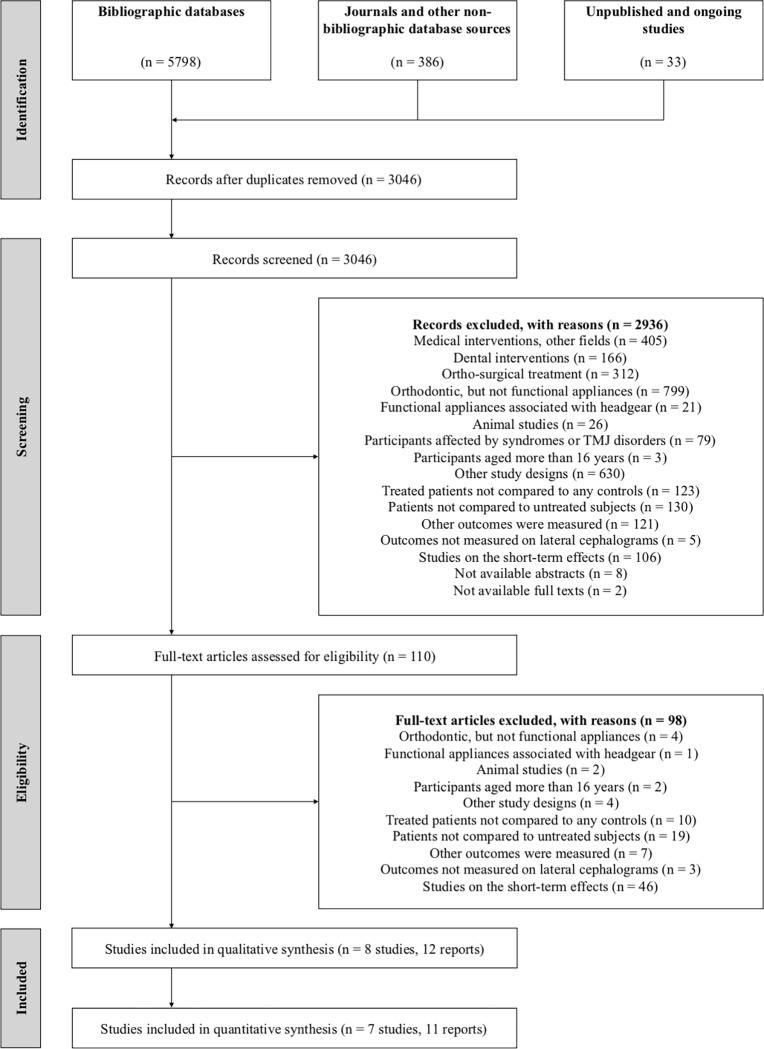
PRISMA flow diagram.